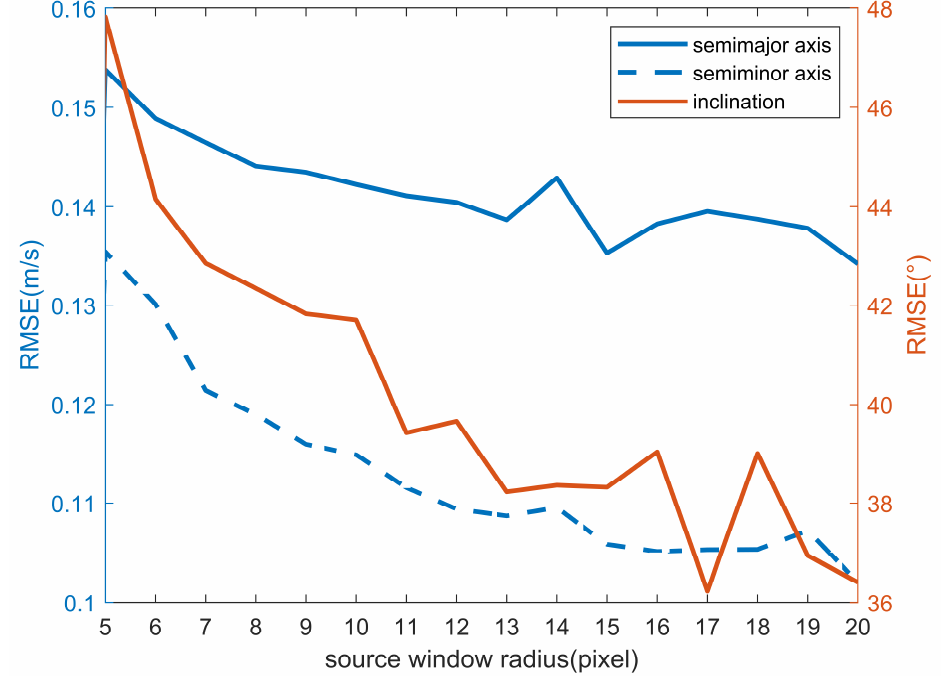
Figure 3. The RMSE of semimajor (solid blue line), semiminor (blue dotted line) axis, and inclination (solid red line) under different source window radius r .